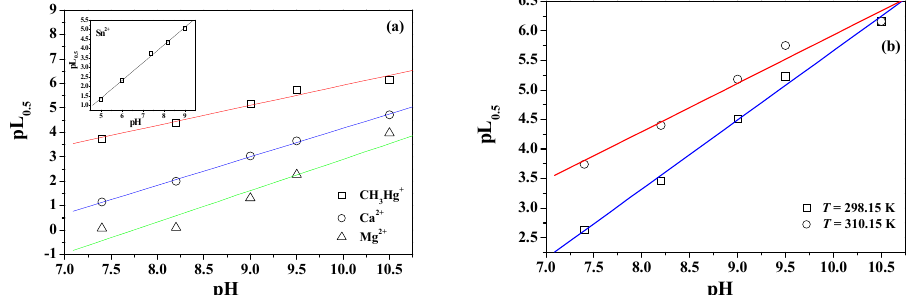
Figure 12. Dependence of pL 0 . 5 on pH. ( a ) pL 0 . 5 values calculated at T = 298.15 K and I = 0.15 mol dm-3; ( b ) pL0.5 values of CH 3 Hg + /Dop − system calculated at I = 0.15 mol dm − 3 , pH = 7.4, and T = 298.15 and 310.15